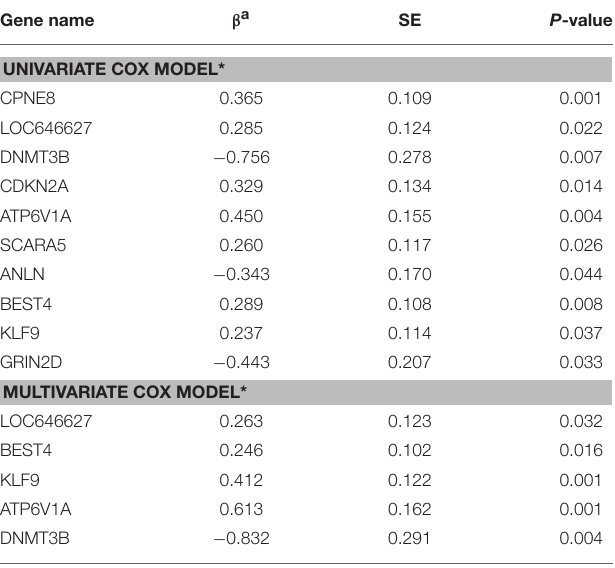
TABLE 2 | DEGs statistically significantly associated with the overall survival time.